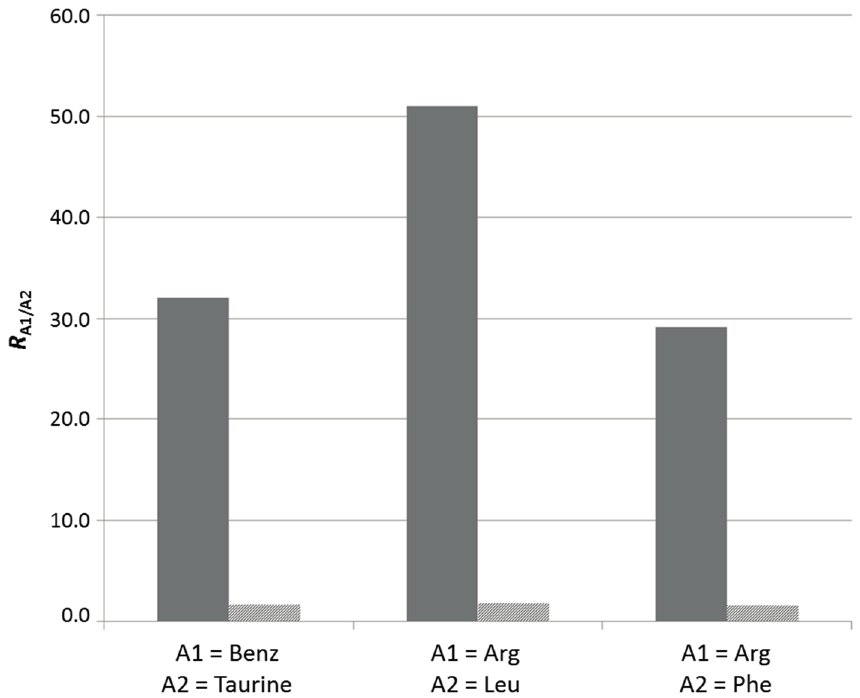
Figure 4. Selective retention of aminated products ( R A1/A2 ) in competition experiments with two different amines, A1 and A2, in the presence of either cellulose (light grey) or dT n on cellulose (dark